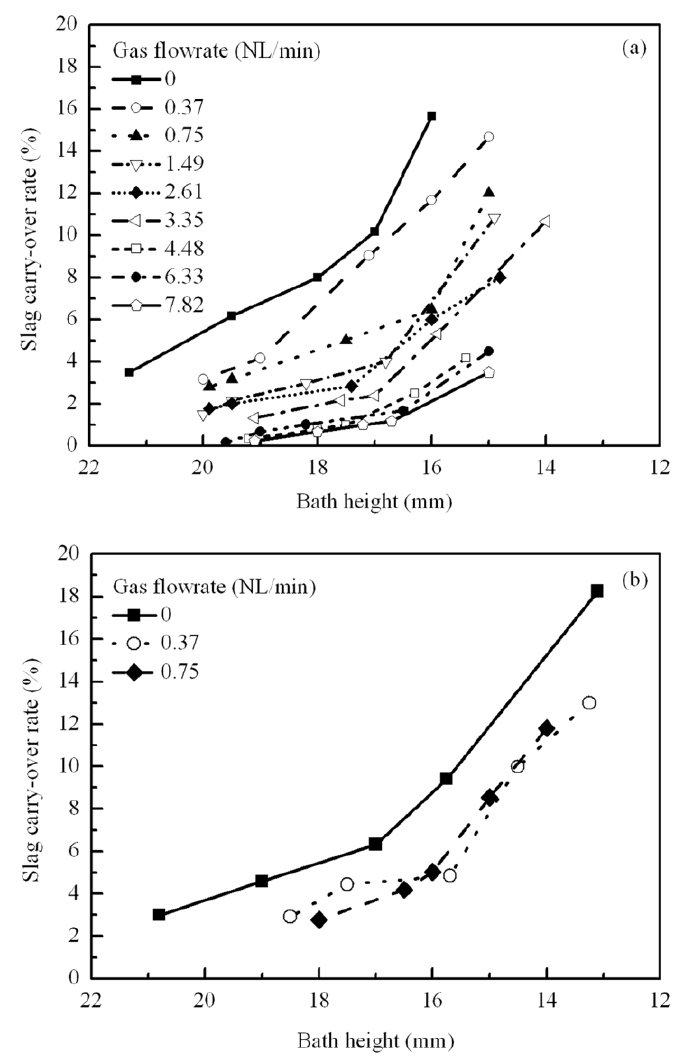
Figure 7. The variation of slag carry-over rate with bath height under various gas flow rates at the slag thickness of ( a ) 10 mm and ( b ) 24 mm.